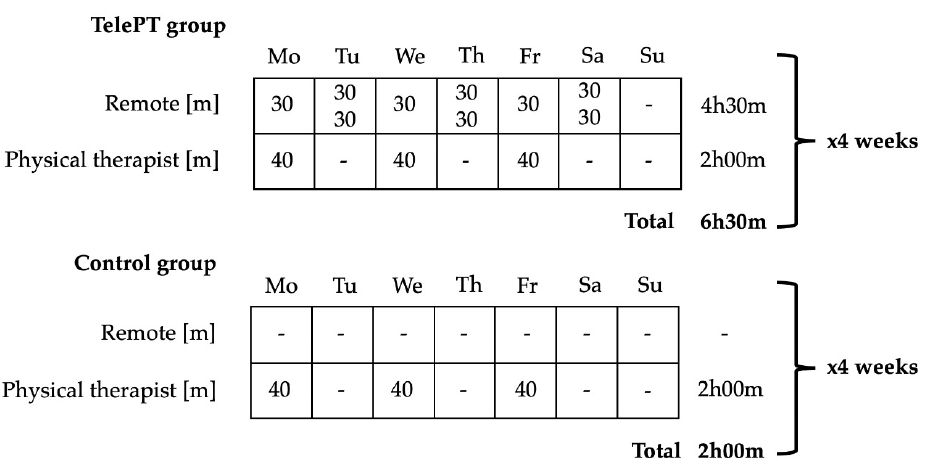
Figure 2. Protocol dose and session distribution during an example week.